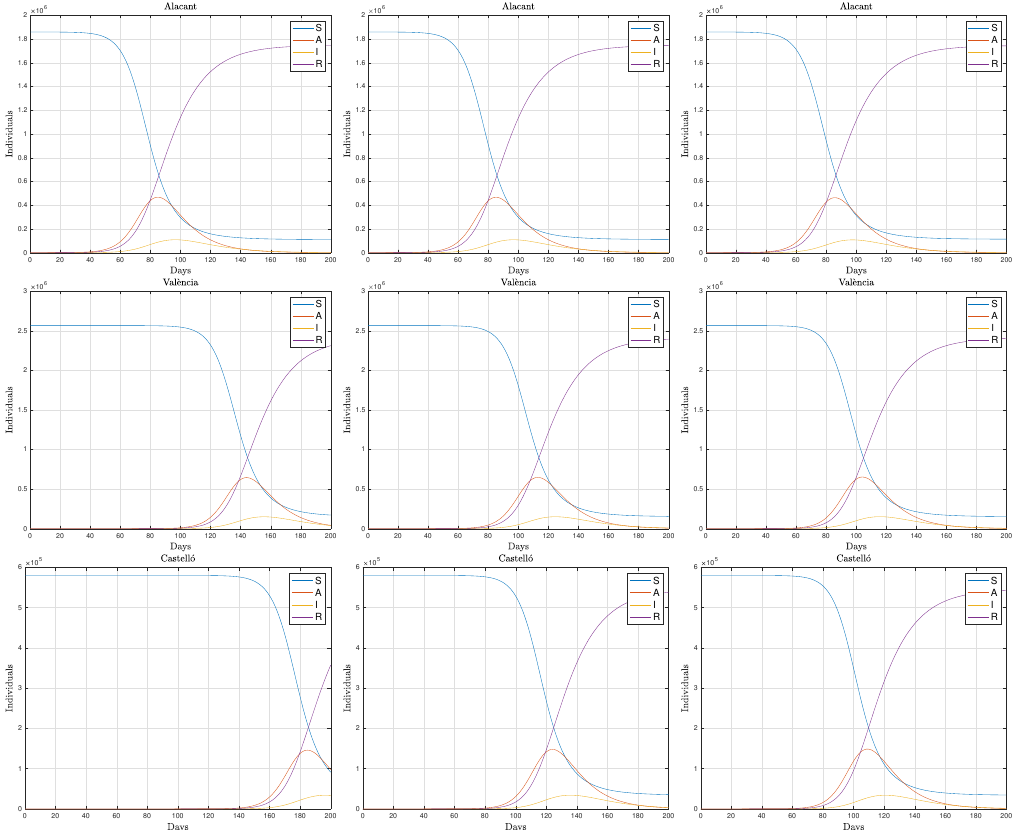
Figure 2. Simulation of the evolution of COVID-19 in the different provinces of the Valencian Autonomous Community, assuming that initially Alacant has 40 asymptomatic infectious individuals and Castelló and València have none, and considering different mobility restrictions between provinces. From left to rigth: very resticted mobility, restricted mobility and unrestricted